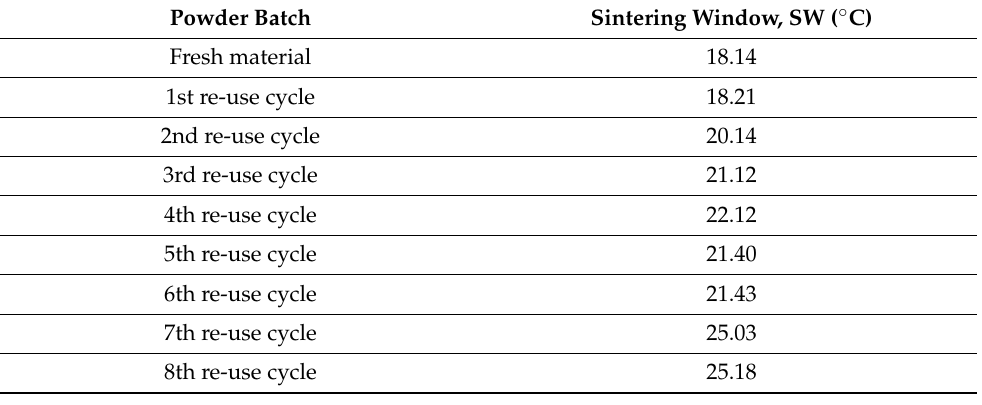
Table 6. Calculated sintering window of Laser PP CP 75 after four re-use